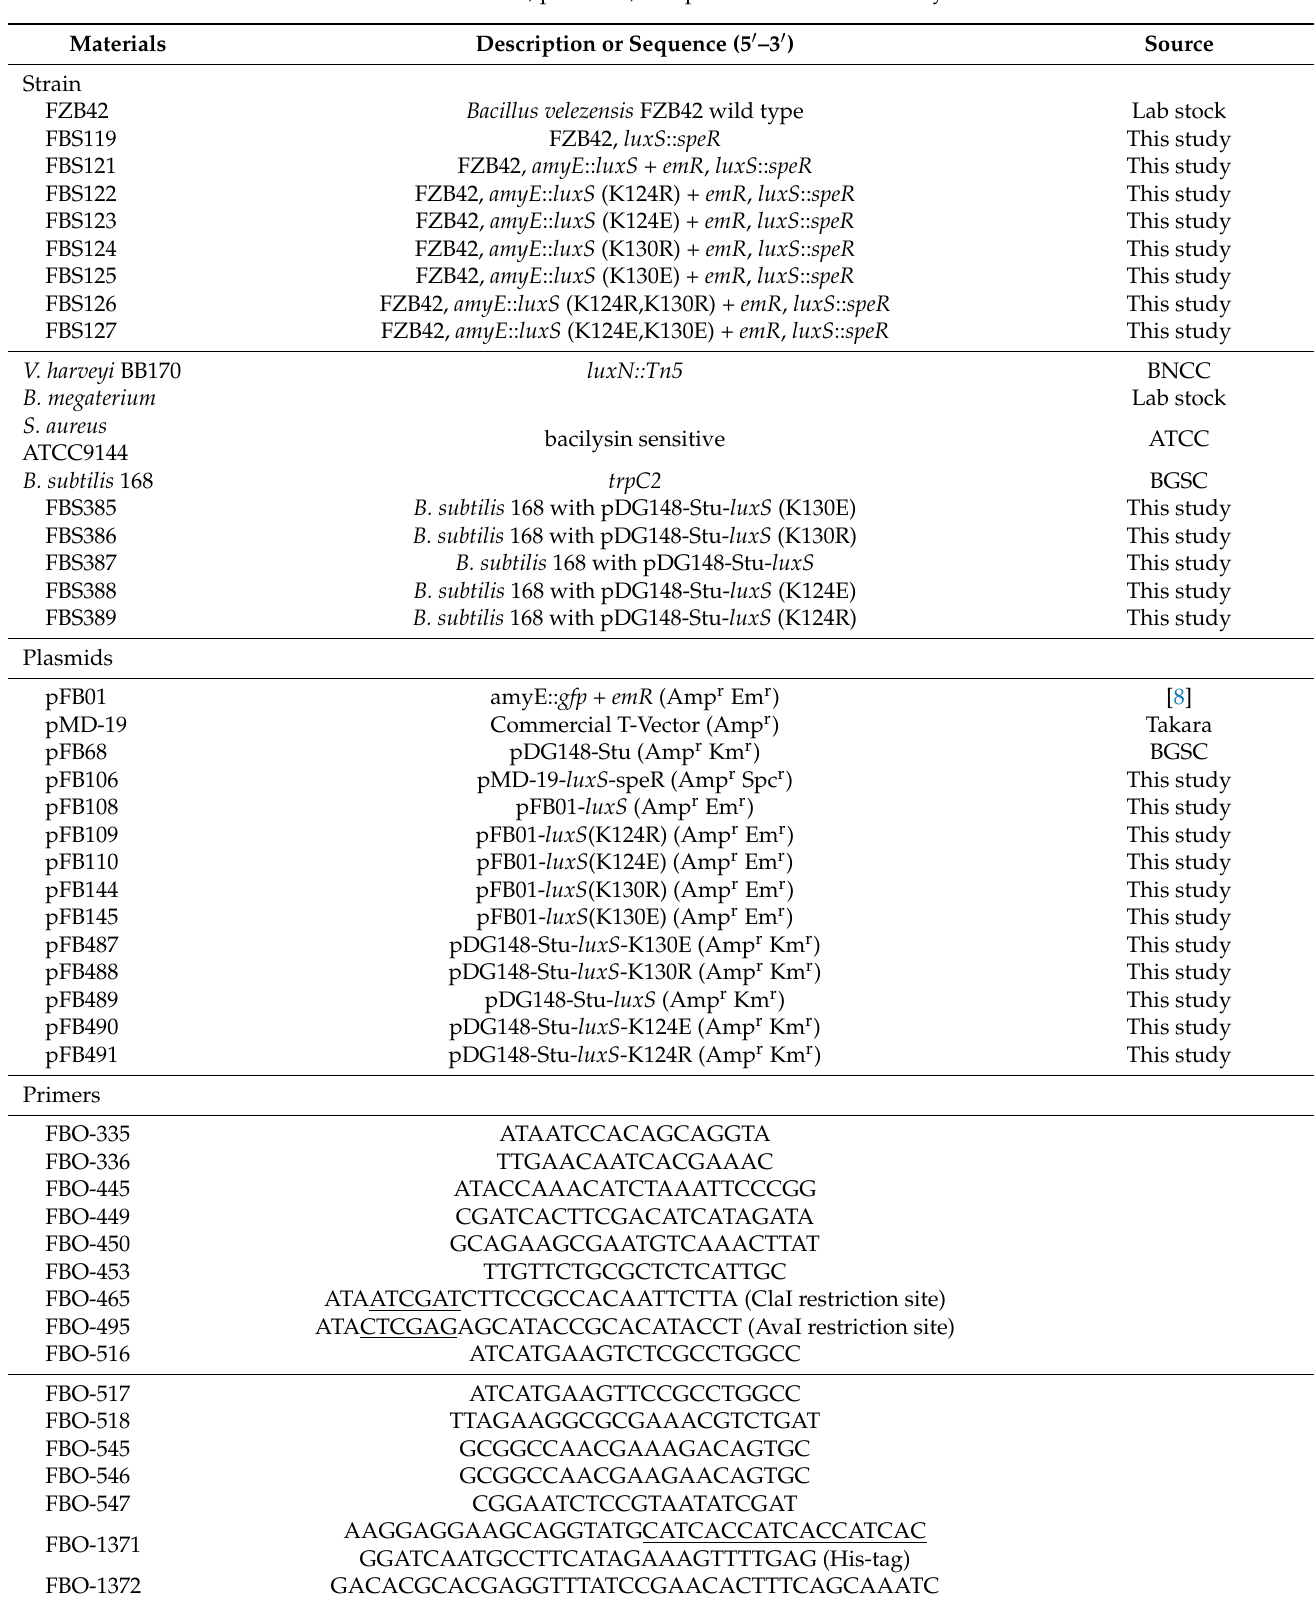
Table 1. Strains, plasmids, and primers used in this